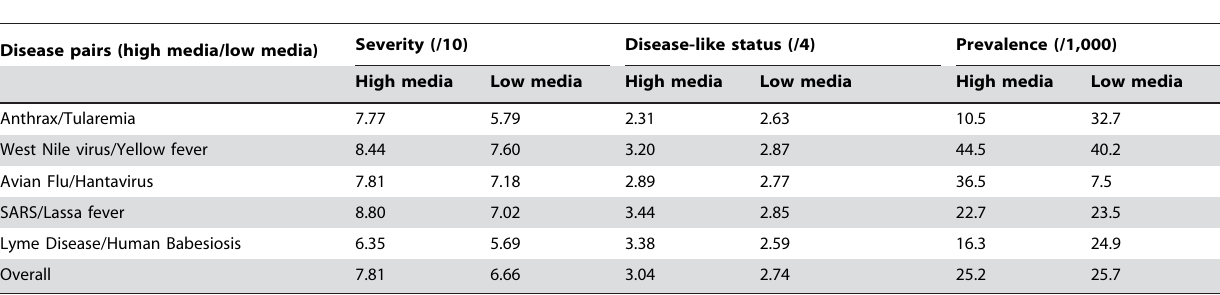
Table 3. Means for Each Infectious Disease: Experiment 1.